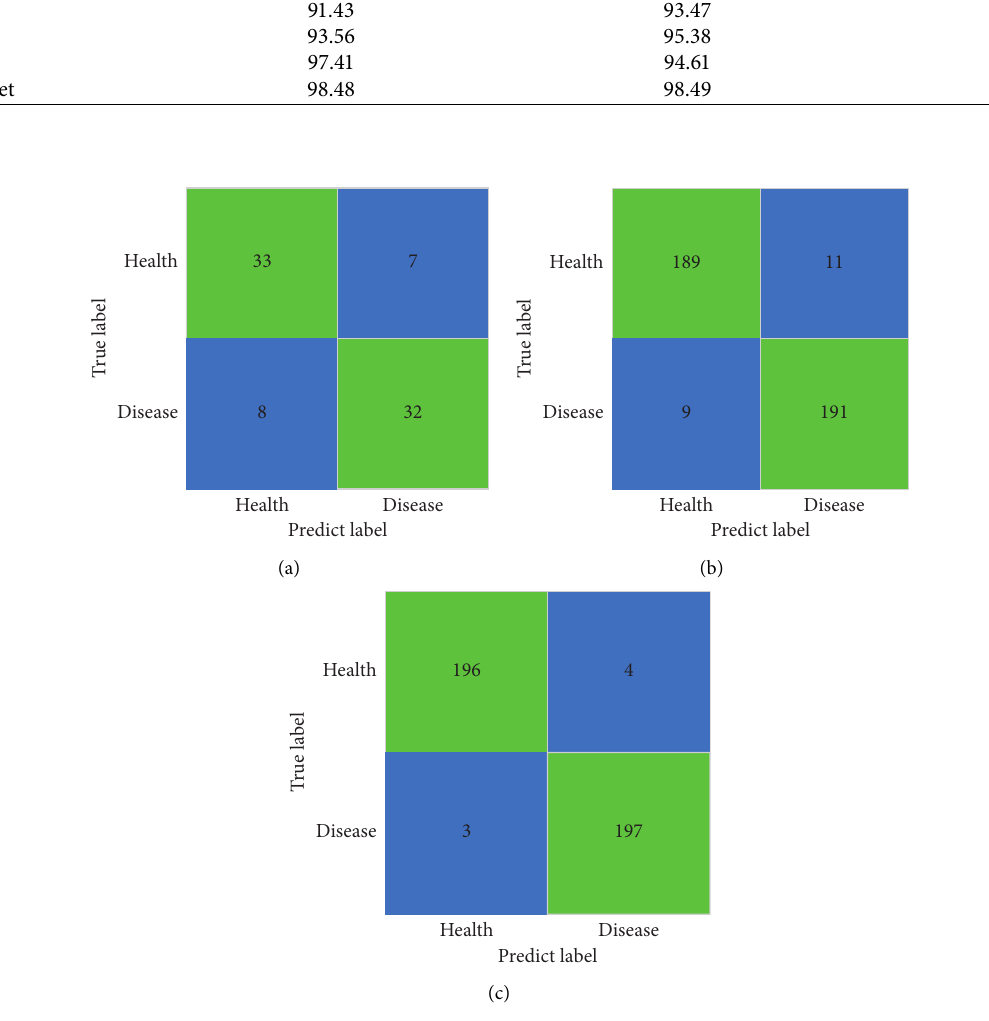
Figure 17: Confounding matrix of different data processing methods. (a) Undersampling +ResNet, (b) oversampling+ ResNet, and (c) GAN+ResNet.